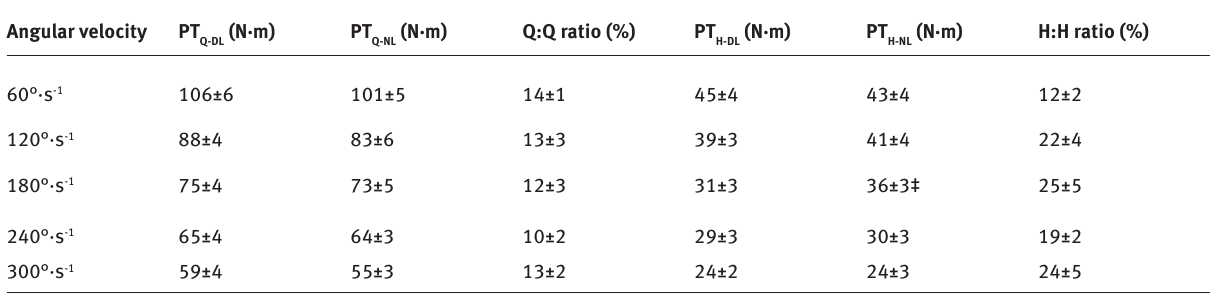
Table 3: Peak muscle torque in the monitored velocities and its comparison between the dominant and non-dominant limbs (Data are pre- sented in mean ±